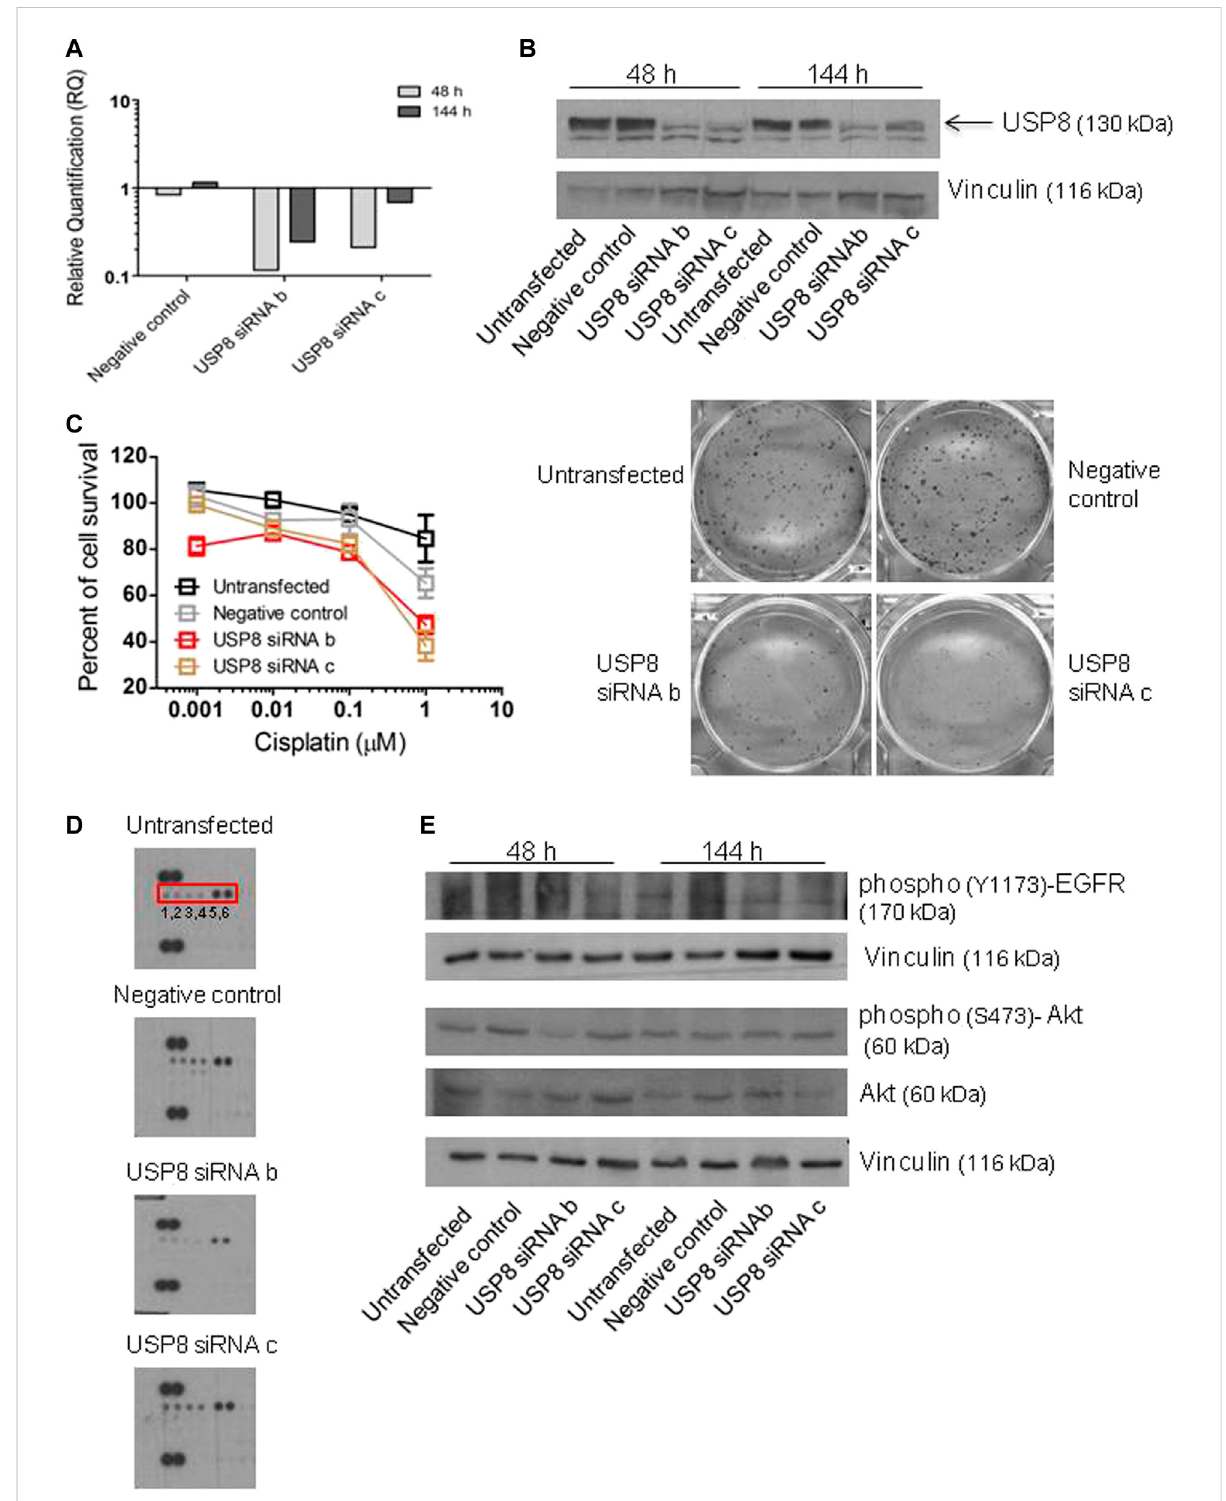
FIGURE 2 Survival-relatedfeaturesofIGROV-1/Pt1cellsuponUSP8moleculartargeting. (A) QuantitativeRT-PCRofUSP8mRNAlevelsinIGROV-1/Pt1at different time points after siRNA transfection; untransfected cells were the calibrator; GAPDH was used as housekeeping gene. (B) USP8 protein levelswereanalyzedbywesternblotatdifferenttimepointsaftersiRNAtransfection.Thereportedexperimentisrepresentativeofthree.Vinculinwas usedasloadingcontrol.Quanti fi cationofthebandintensitywasperformedwithImageJ,withnormalizationtovinculinandtheobtainedvalues